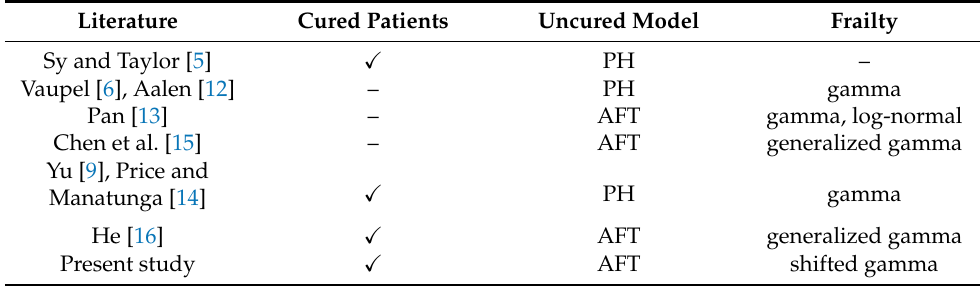
Table 1. Selected related literature and elements of our proposed method. Elements of our proposed method and relationship among existing studies. The symbol (cid:88) means “Considered”. PH and AFT means proportional hazard and accelerated failure time models, respectively. Literature Cured Patients Uncured